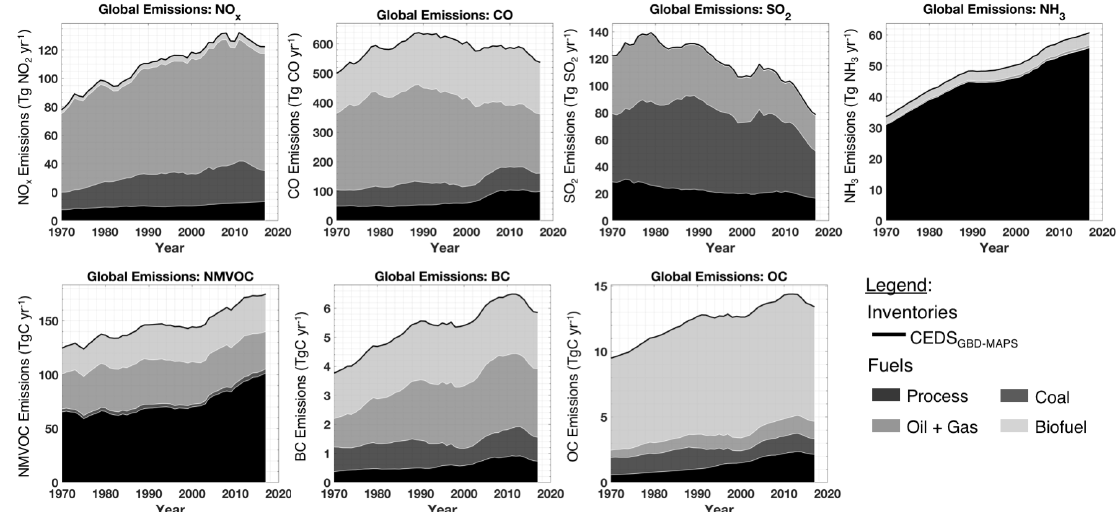
Figure 7. Time series of global annual emissions of NO x , CO, SO 2 , NH 3 , NMVOCs, BC, and OC for all sectors, colored by fuel group.